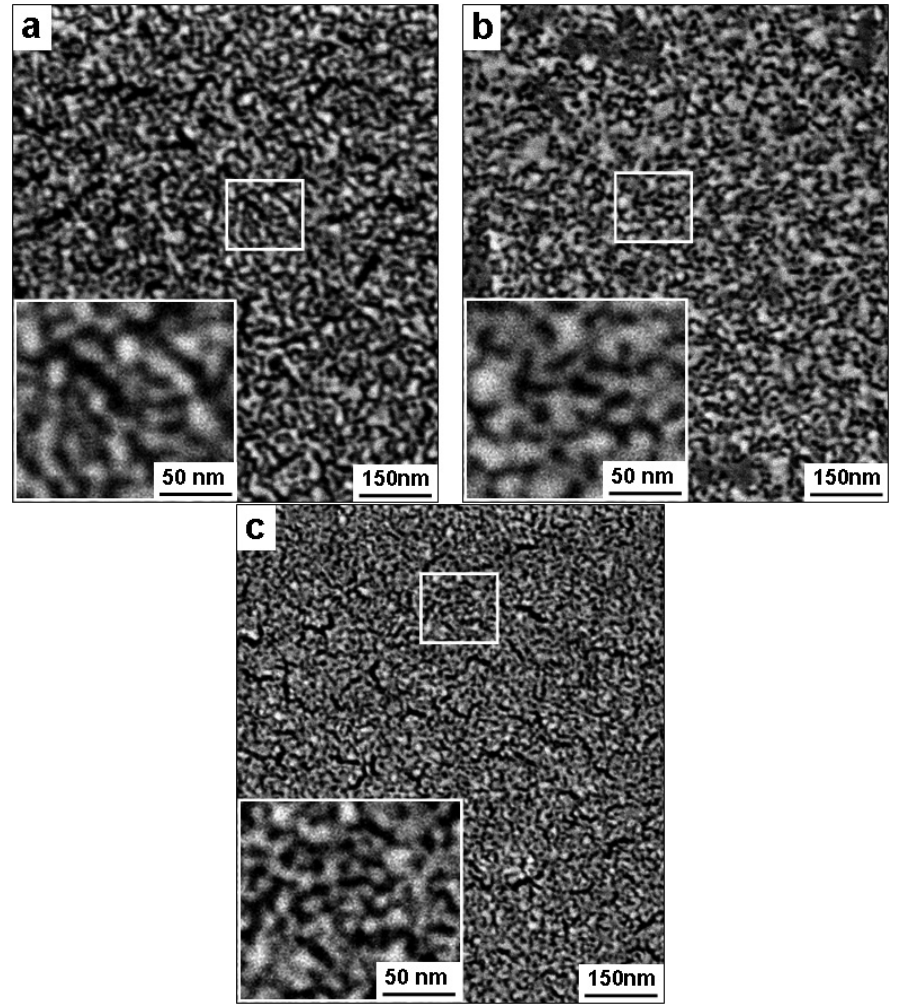
Figure 6. Microstructure of np-Pd produced from 90 nm PdNi precursor alloy films with (a) 18 at % Pd, (b) 22 at % Pd, and (c) 25 at % Pd. All films were dealloyed in 25% sulfuric acid and exhibited an open, sponge-like structure with ligaments and pores smaller than 10 nm. Cracks were observed in the films obtained from 18 at % Pd and 25 at % Pd precursor films, but not in the 22 at % Pd film shown in